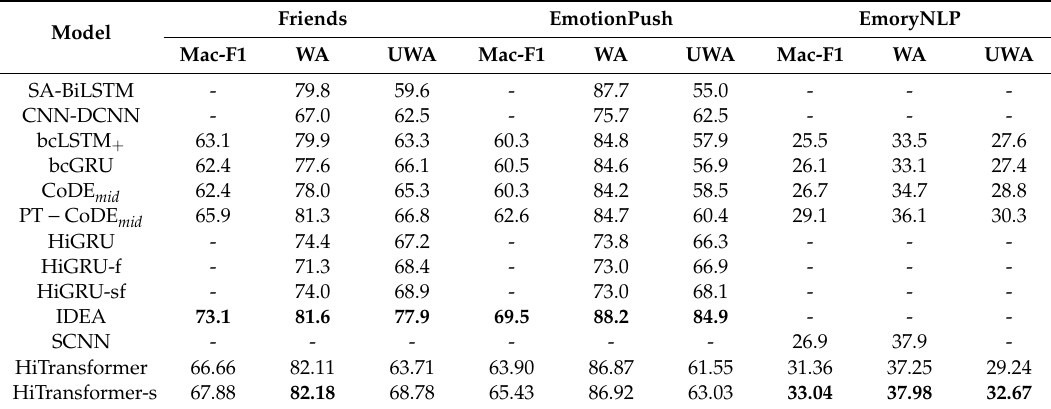
Table 3. Testing results on Friend, EmotionPush, and EmoryNLP.